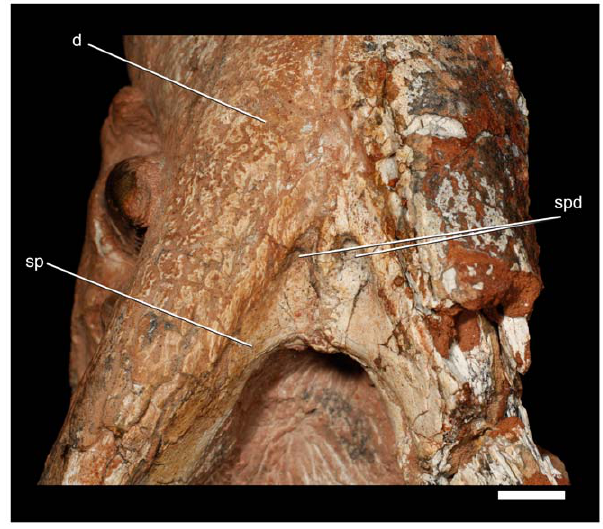
Figure 16. Detail of the ventral portion of symphysis of Pissarrachampsasera (LPRP/USP 0018). Scale bar equals 1 cm.